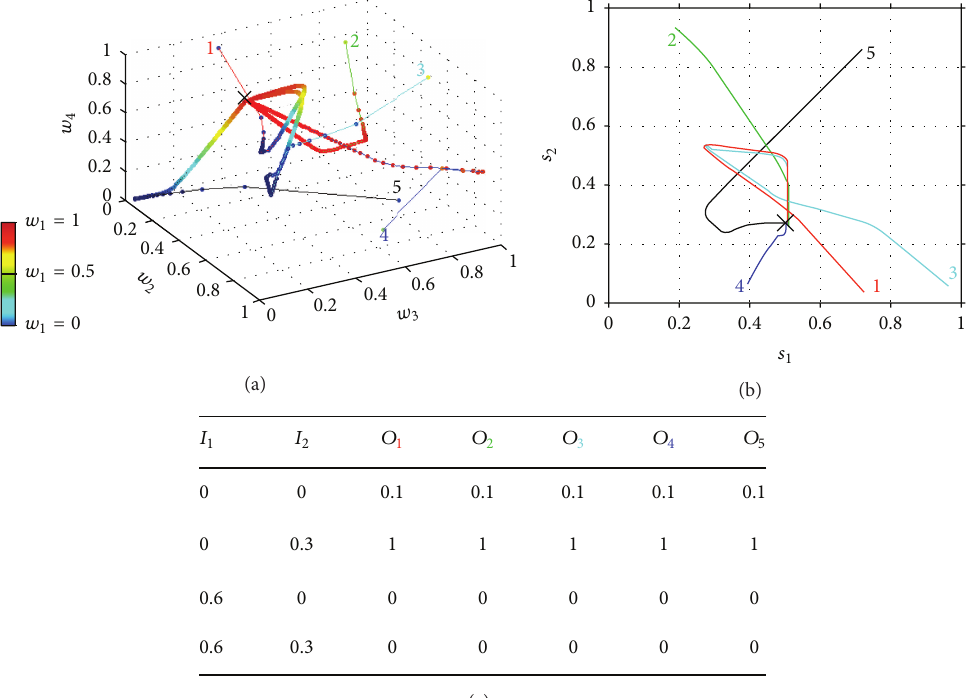
Figure 3: Evolution of gate circuit parameters when considering both intrinsic and synaptic plasticity. Five program simulations (5 thin colored lines) are depicted, starting with different initial weights and shifts. (a) Evolution of weights: each coordinate ( 𝑤 2 , 𝑤 3 , 𝑤 4 ) represents the set of synaptic weights in each iteration, with the color of the point representing the value of weight 𝑤 1 . Along iterations, all lines converge to the same coordinate ( 𝑤 1 , 𝑤 2 , 𝑤 3 , 𝑤 4 ) = (1, 0, 0.5, 0.5). (b) After 5000 iterations, the shift parameters of the activation function of the SG neuron ( 𝑠 1 ) and of the T neuron ( 𝑠 2 ) also converge to a certain point (0.5, 0.27). (c) With the final set of weights and shift parameters, the probability of a CT neuron’s firing is given by the table being 𝐼 1 the mechanoreceptor input probability and 𝐼 2 the nociceptive input probability.